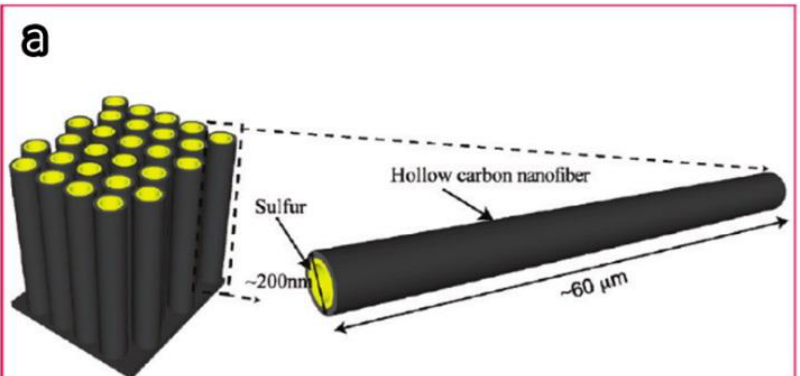
Figure 16. Schematic demonstration and SEM images of the hollow CNF/sulfur composite structure. ( a ) The high aspect ratio of the hollow CNF for the effective trapping of polysulfides; ( b ) the fabrication process of the CNF/sulfur cathode structure; ( c ) the contrast of the anodic aluminum oxide (AAO) template before and after carbon coating and sulfur infusion; ( d ) SEM image of the AAO template after carbon coating; and ( e ) hollow CNF encapsulated sulfur after etching away the AAO template